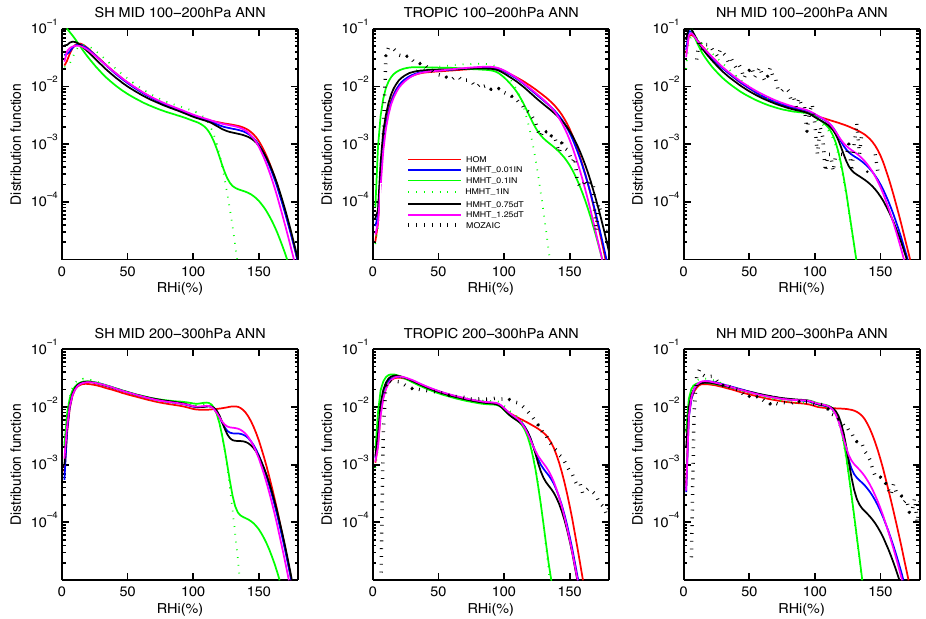
Fig. 6. Frequency of occurrence of RH i in the SH middle latitudes (60 ◦ S–30 ◦ S) (SH MID, left panel), in the tropics (30 ◦ S–30 ◦ N) (TROPIC, middle panel), and the NH middle latitudes (30 ◦ N–60 ◦ N) (NH MID, right panel) at 100–200hPa (upper panel) and at 200–300hPa (lower panel) from all simulations listed in Table 1. Observations from MOZAIC data in the tropics and in the NH middle latitudes are also